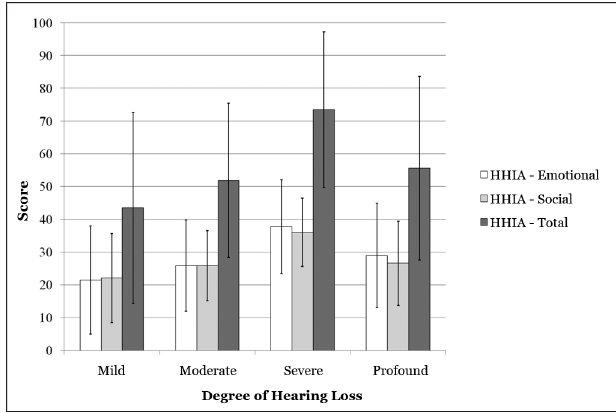
Figure 1. Median and standard deviation of the total score and that from the social and emotional subscales for Group B, in accordance with the hearing loss in the best ear